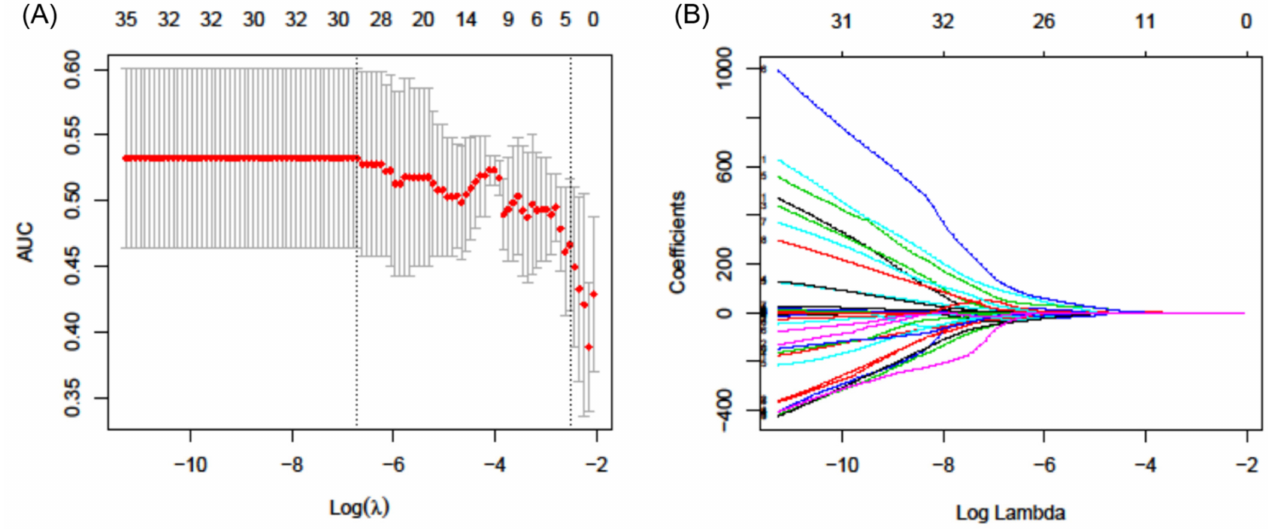
Figure 1. F-18 fluorodeoxyglucose positron emission tomography/computed tomography radiomic feature selection performed by the least absolute shrinkage and selection operator (Lasso) regularization method. ( A ) Area under the curve was drawn versus log ( λ ) by the 5-fold cross-validation. The vertical dotted line defines the optimal λ value. The optimal λ of 0.0012, with log ( λ ) of − 6.7061 was selected; ( B ) Lasso coefficient profiles of the 48 potential PET features as selected by the t -test. Twenty-seven features were selected with the optimal λ